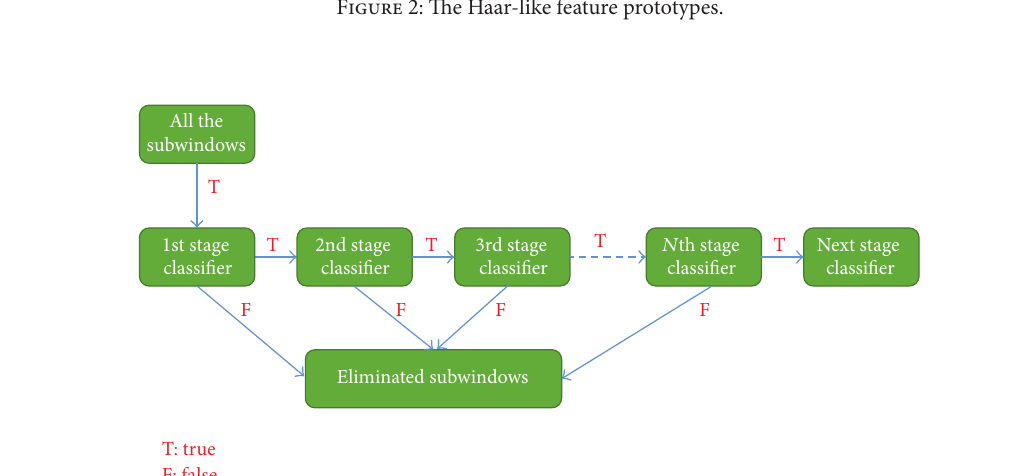
Figure 2: The Haar-like feature prototypes.